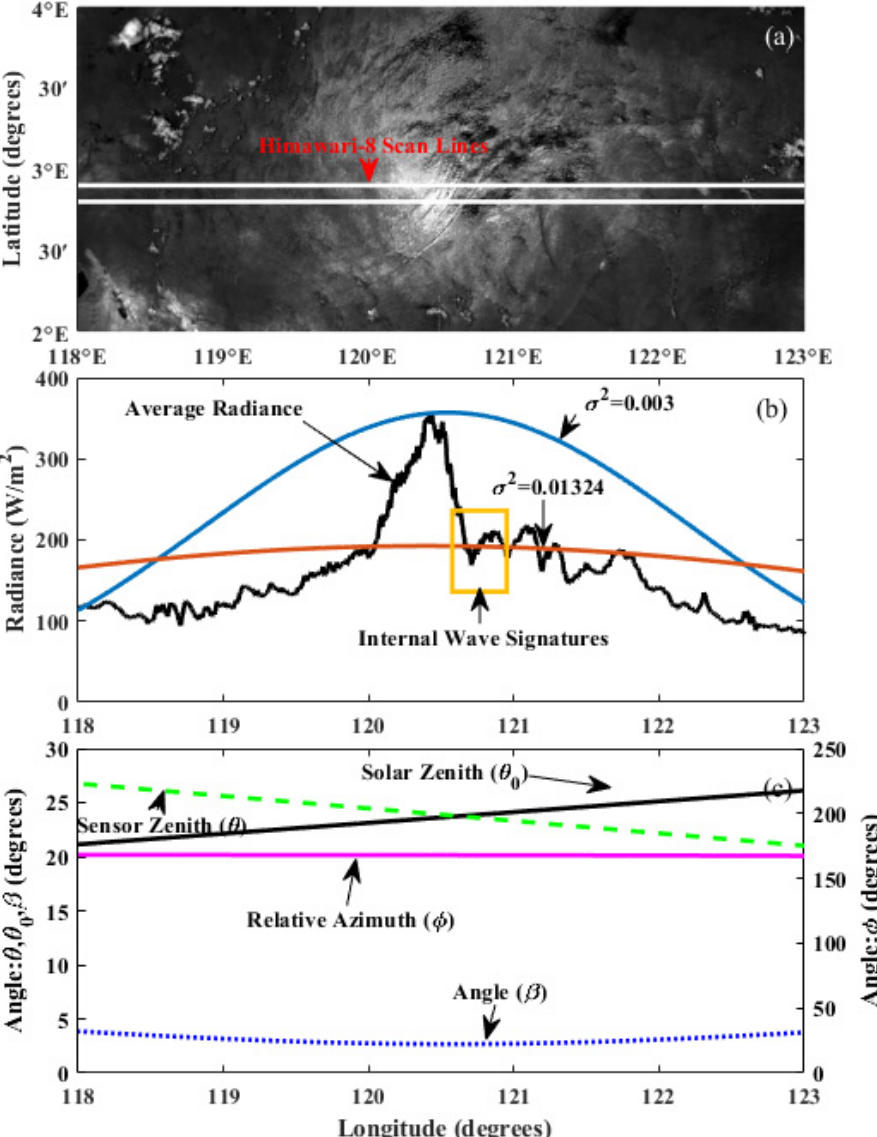
Figure 10. Analysis of the image acquired on 21 September 2020 at 05:20 UTC. ( a ) shows part of the Himawari-8 image of the Celebes Sea acquired on 21 September 2020 at 05:20 UTC, and the white solid line represents the scan line of the AHI sensor onboard the Himawari-8 satellite; ( b ) shows curves of the normalized solar radiance calculated with roughness variance ( σ 2 ) values of 0.003 and 0.01324 and the average measured radiance along the scan line, and the yellow box marks the position of the internal solitary waves. The blue and orange curves represent the radiance information of the sea surface background and internal solitary waves, respectively; ( c ) shows the changes in the solar zenith angle ( θ 0 ), sensor zenith angle ( θ ), relative azimuth angle ( ϕ ), and surface facet tilt ( ꞵ ) along the AHI sensor scan line. The solid black line represents the change in the solar zenith angle ( θ 0 ) along the scan line. The green dashed line represents the change in the sensor zenith angle ( θ ) along the scan line. The purple solid line represents the relative azimuth angle ( ϕ ) along the scan line. The blue dotted line represents the change in surface facet tilt ( ꞵ ) along the scan line.